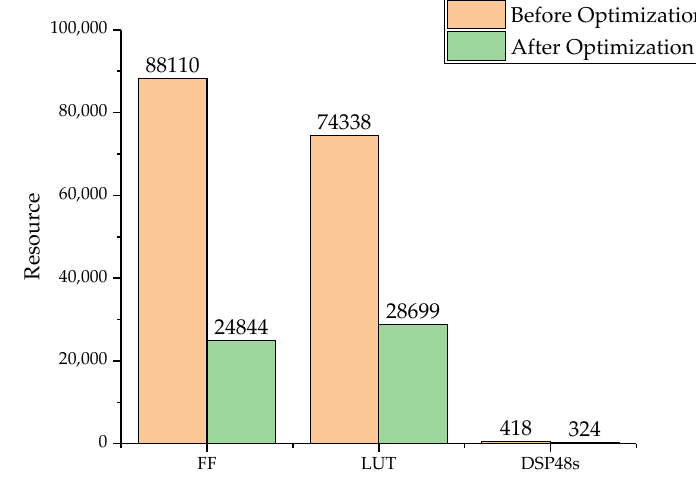
Figure 14. Calculation units’ resource consumption before and after optimization.